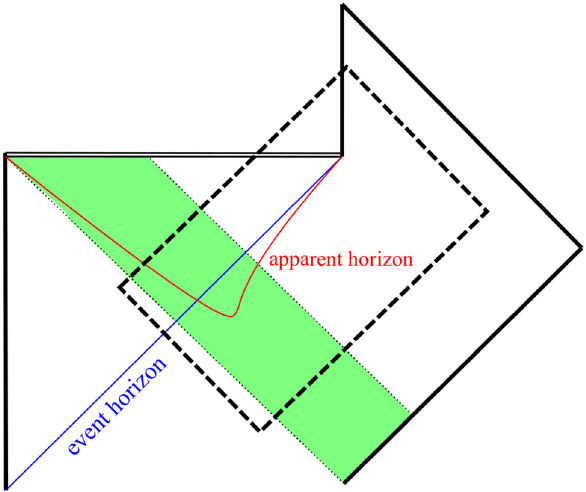
Fig. 6 Causal structure of an evaporating Schwarzschild black hole